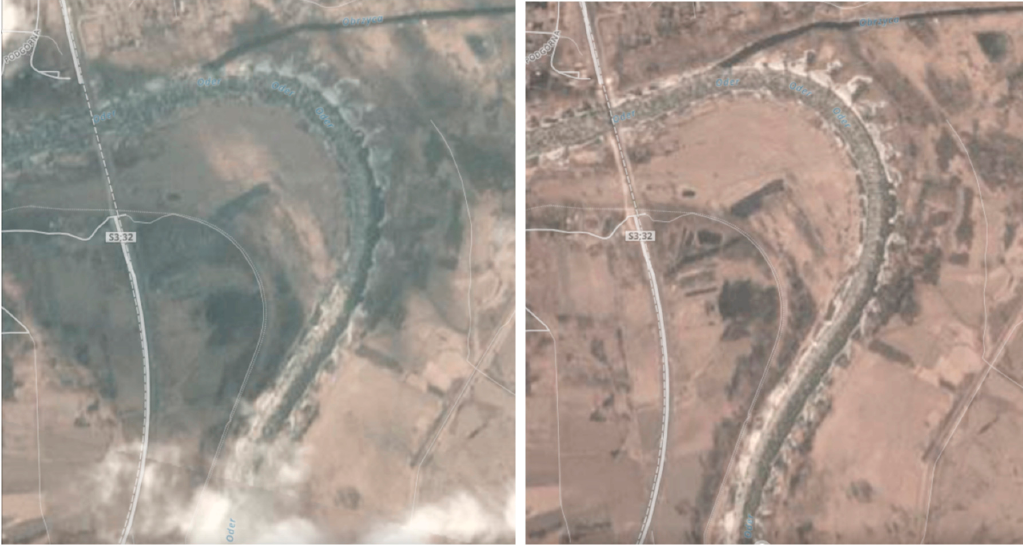
Figure 8. Satellite images (Sentinel 2) of ice movement on the sharp river bend near Cigacice on ( a ) 28 February and ( b ) 2 March 2018.